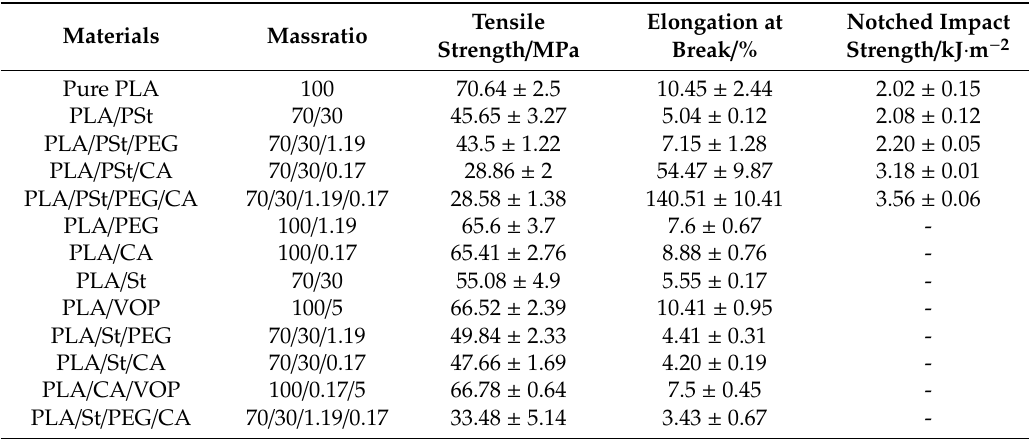
Table 2. Mechanical parameters of di ff erent